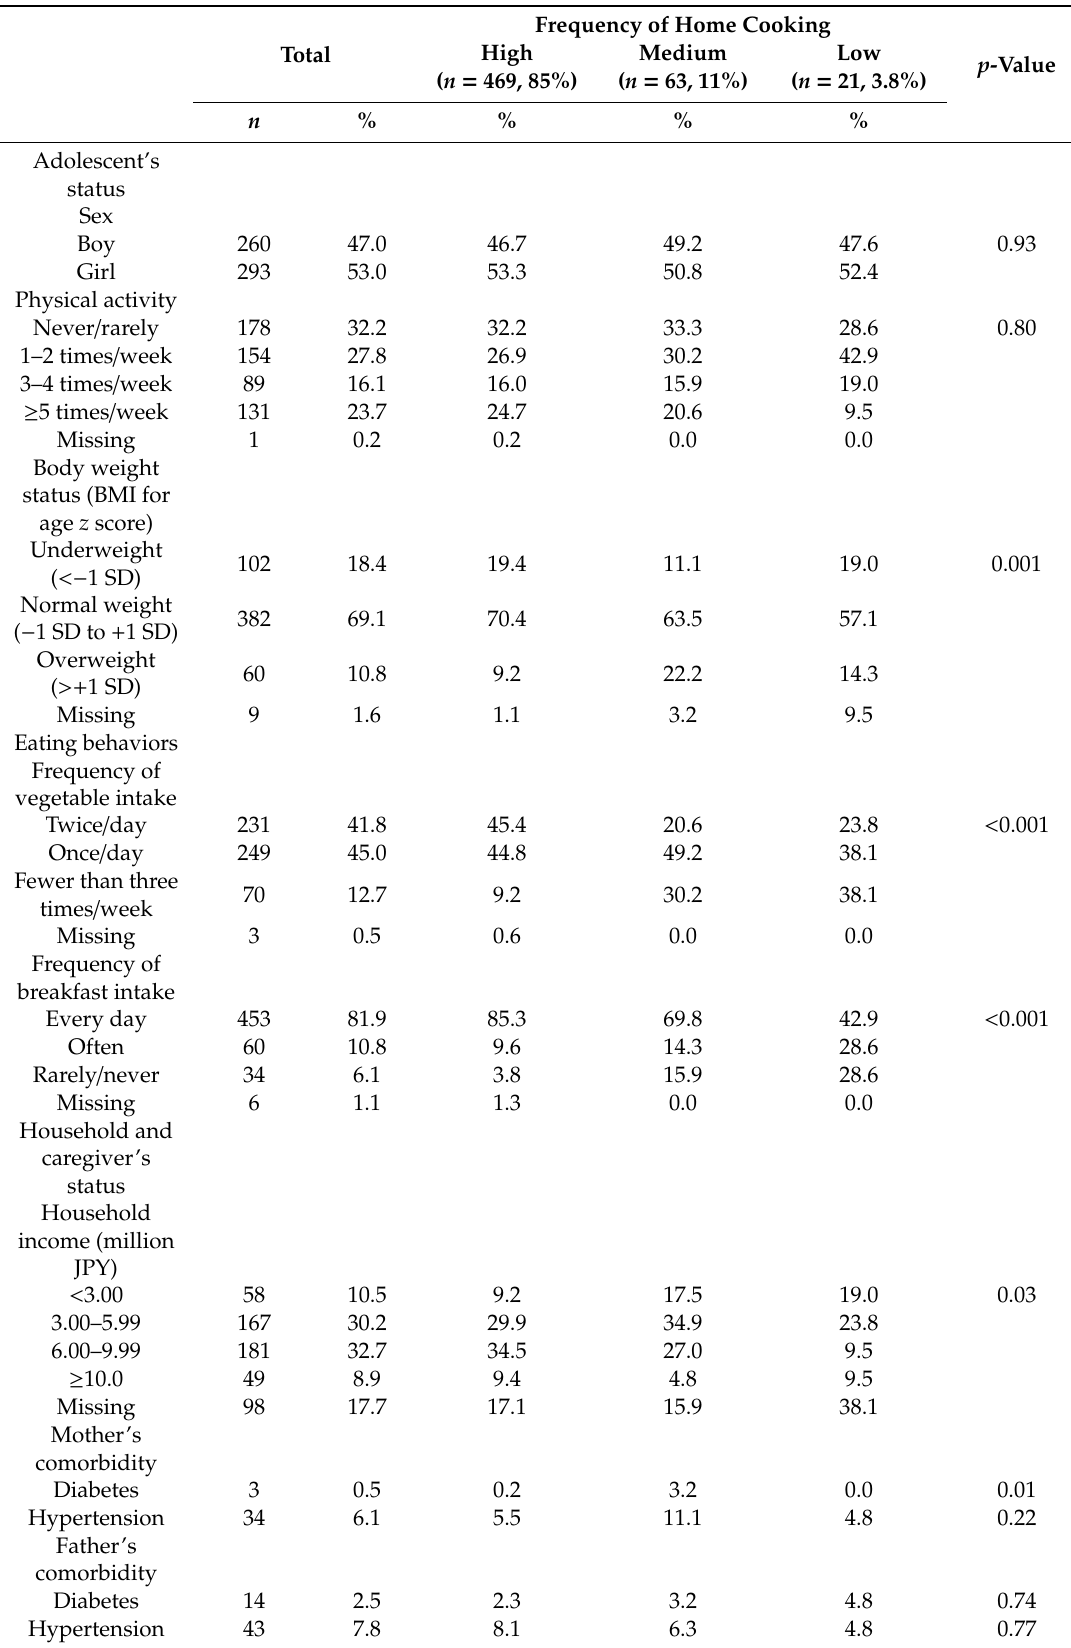
Table 1. Characteristics of adolescents and caregivers enrolled in the study ( n =